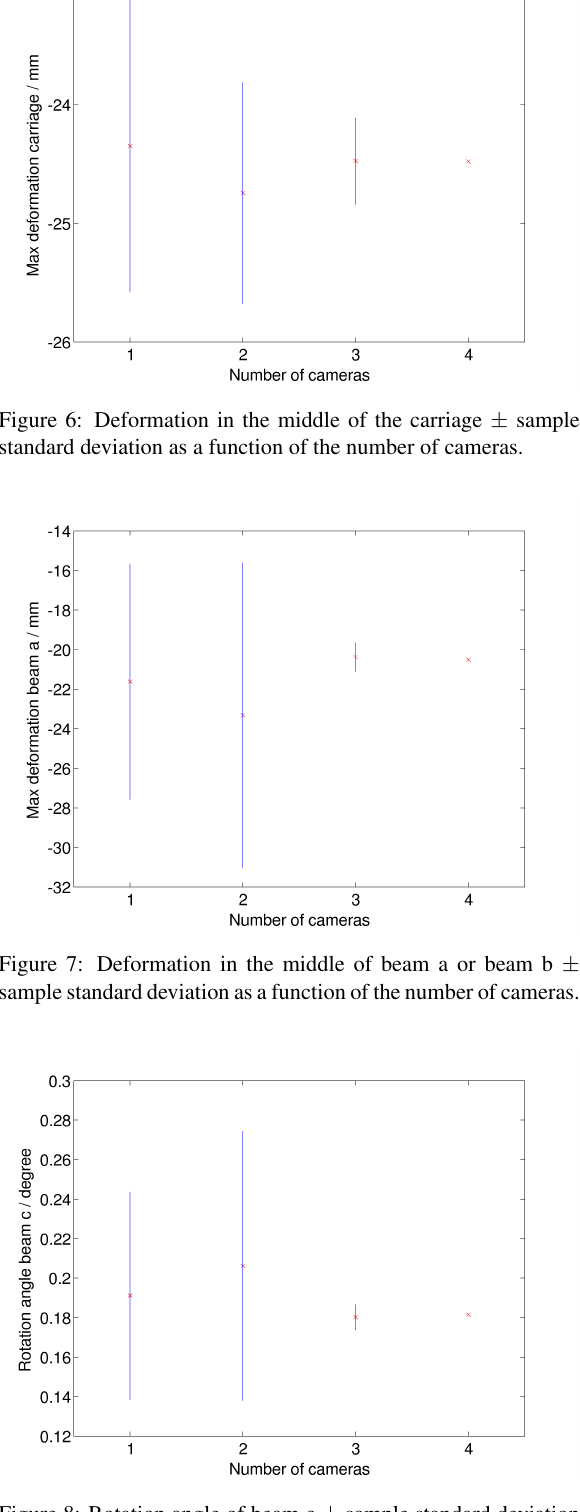
Figure 8: Rotation angle of beam c ± sample standard deviation as a function of the number of cameras.